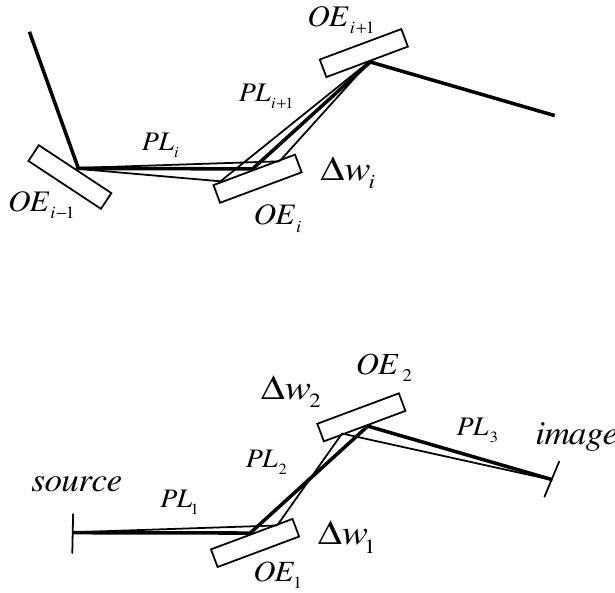
FIG. 6. Top: Variation of one coordinate of one optical element . Bottom: Variation of the coordinates of two neighboring OE i optical elements.